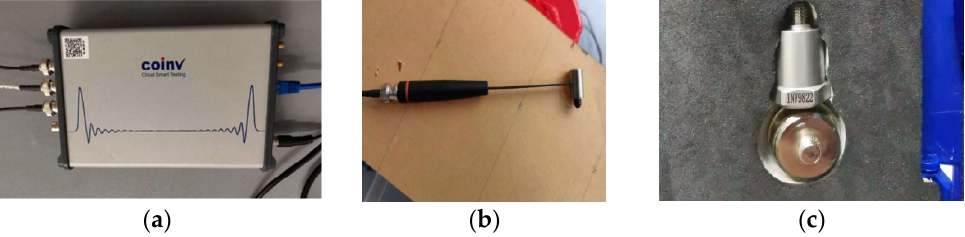
Figure 5. INV3018CT 24-bit high-precision data acquisition instrument, force hammer and sensor. ( a ) Instrument host; ( b ) Stress hammer; ( c ) Sensor. Figure 6. Layout plan of measuring points.